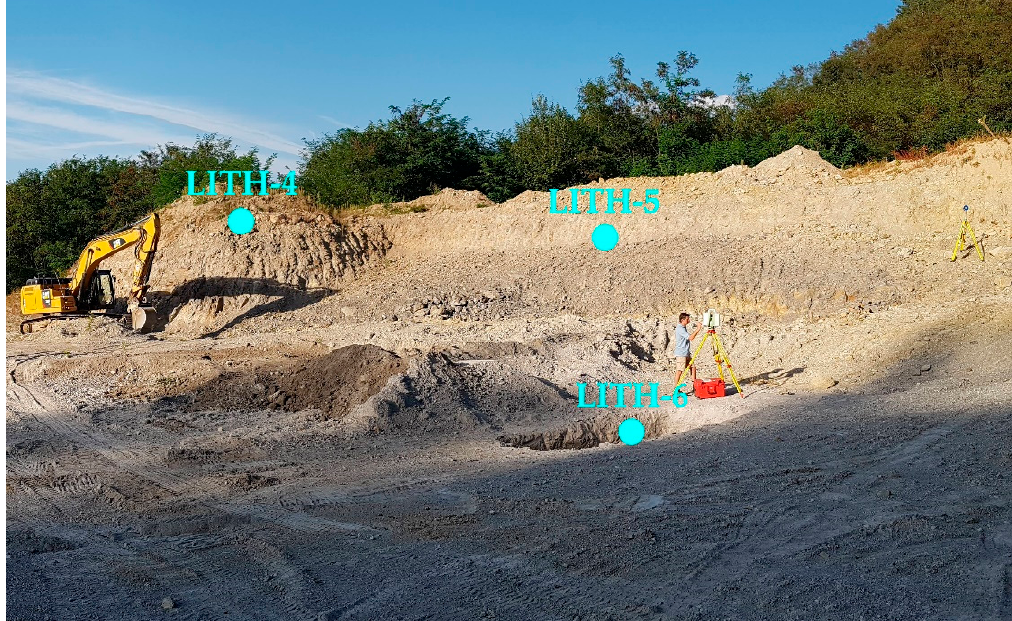
Figure 3. Profile 2—Location of point samples LITH-4–LITH-6.